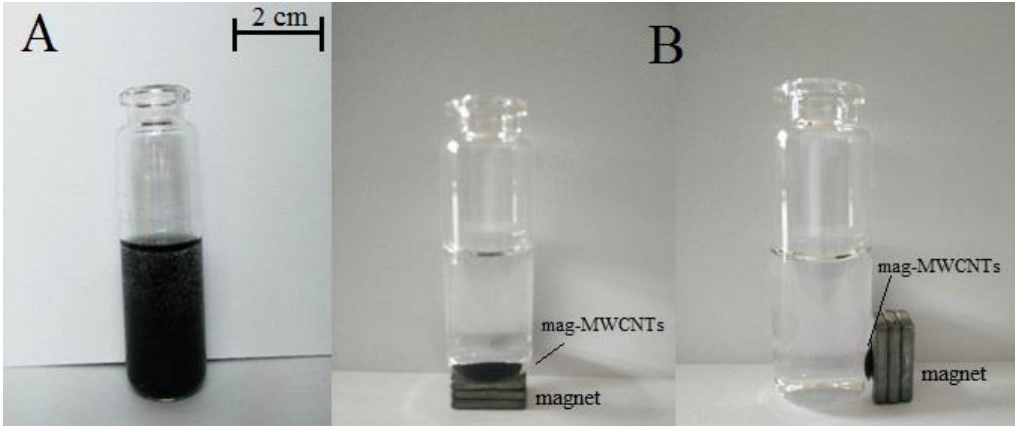
Figure 4. Picture of mag-MWCNTs dispersed in water ( A ) and adhered to the inner side wall of the vial ( B ).